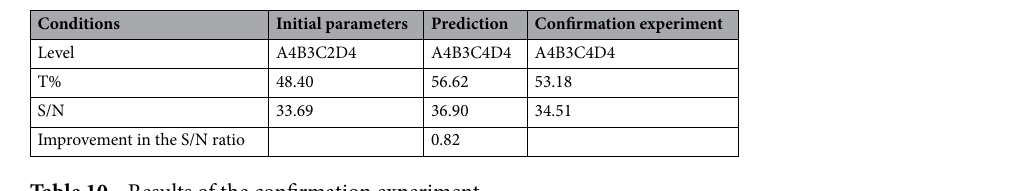
Table 10. Results of the confirmation